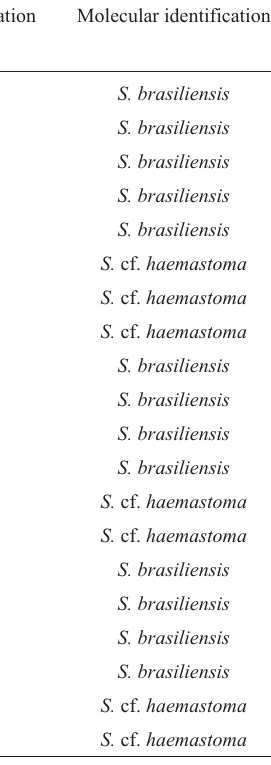
Table 1 - Sampling locations, geographic coordinates, Genbank access number, and morphological identification of the Stramonita